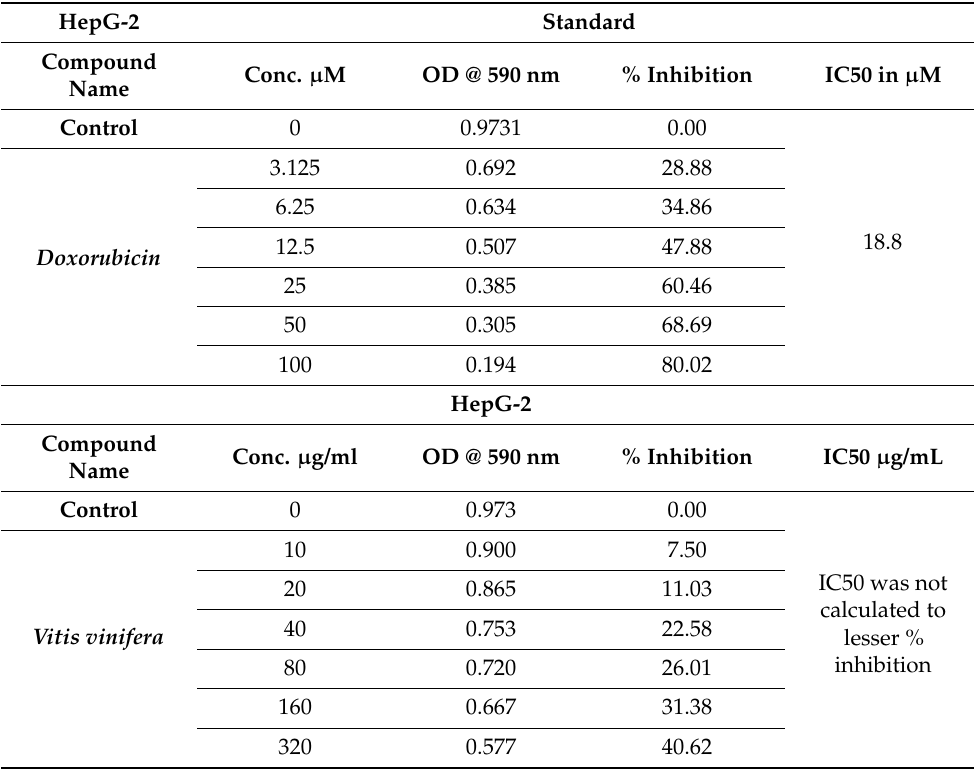
Table 4. MTT assay